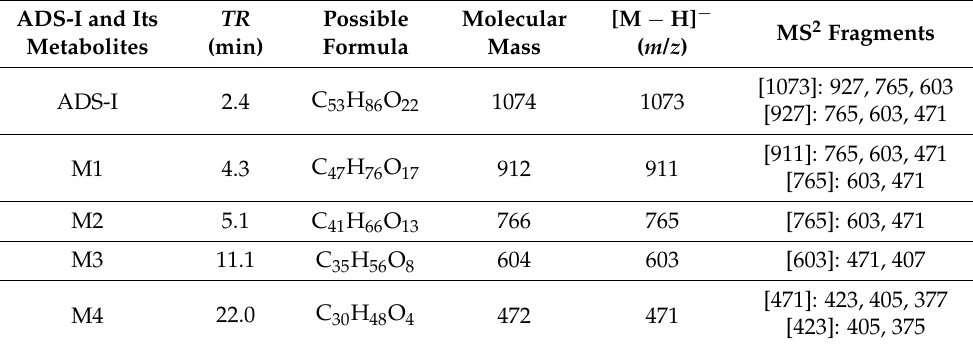
Table 1. The chromatography and mass spectrometry data of ADS-I and its metabolites.